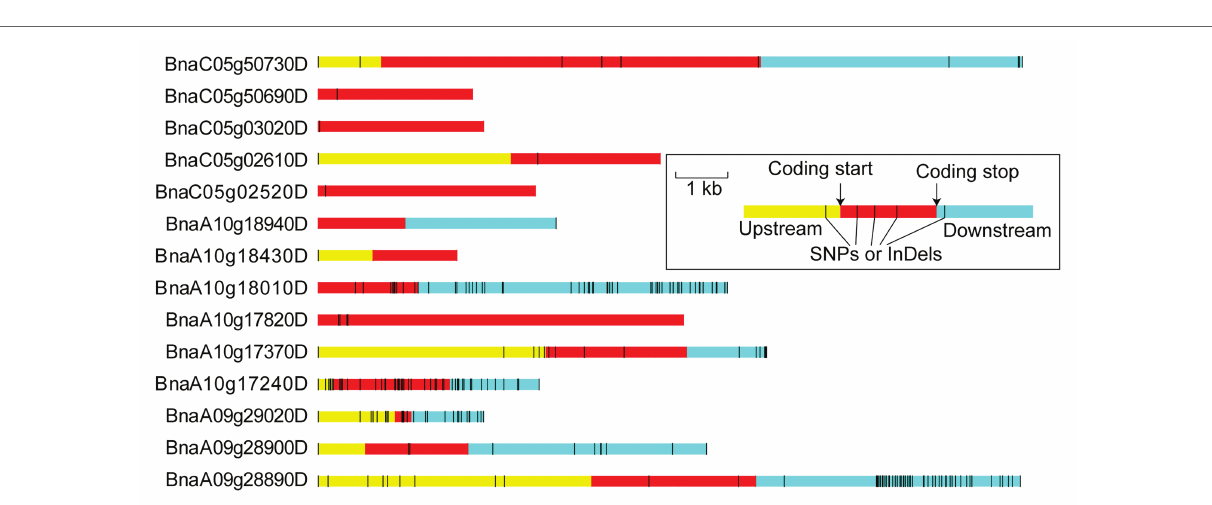
FIGURE 5 | Variation distribution of the candidate genes. The upstream and downstream represent the 5 kb within the region of transcription start and stop sites, respectively. The regions are markers by different colors and the relative physical distance also are shown in the diagram.